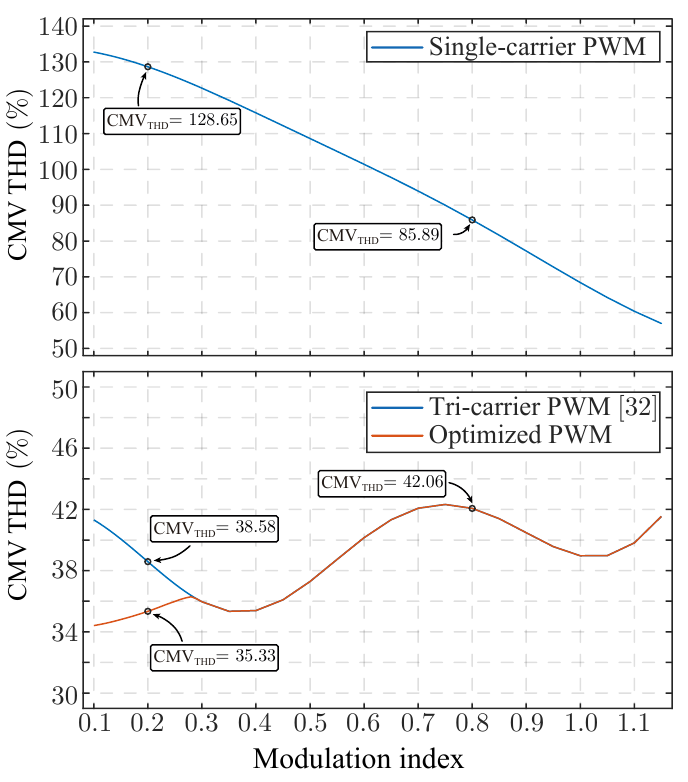
Figure 7. Evaluation of the CMV THD with a modulation index range from 0.1 to 1.15. ( top ) Conven- tional sigle-carrier PWM ( bottom ) Tricarrier PWM [33] and the Optimized PWM.